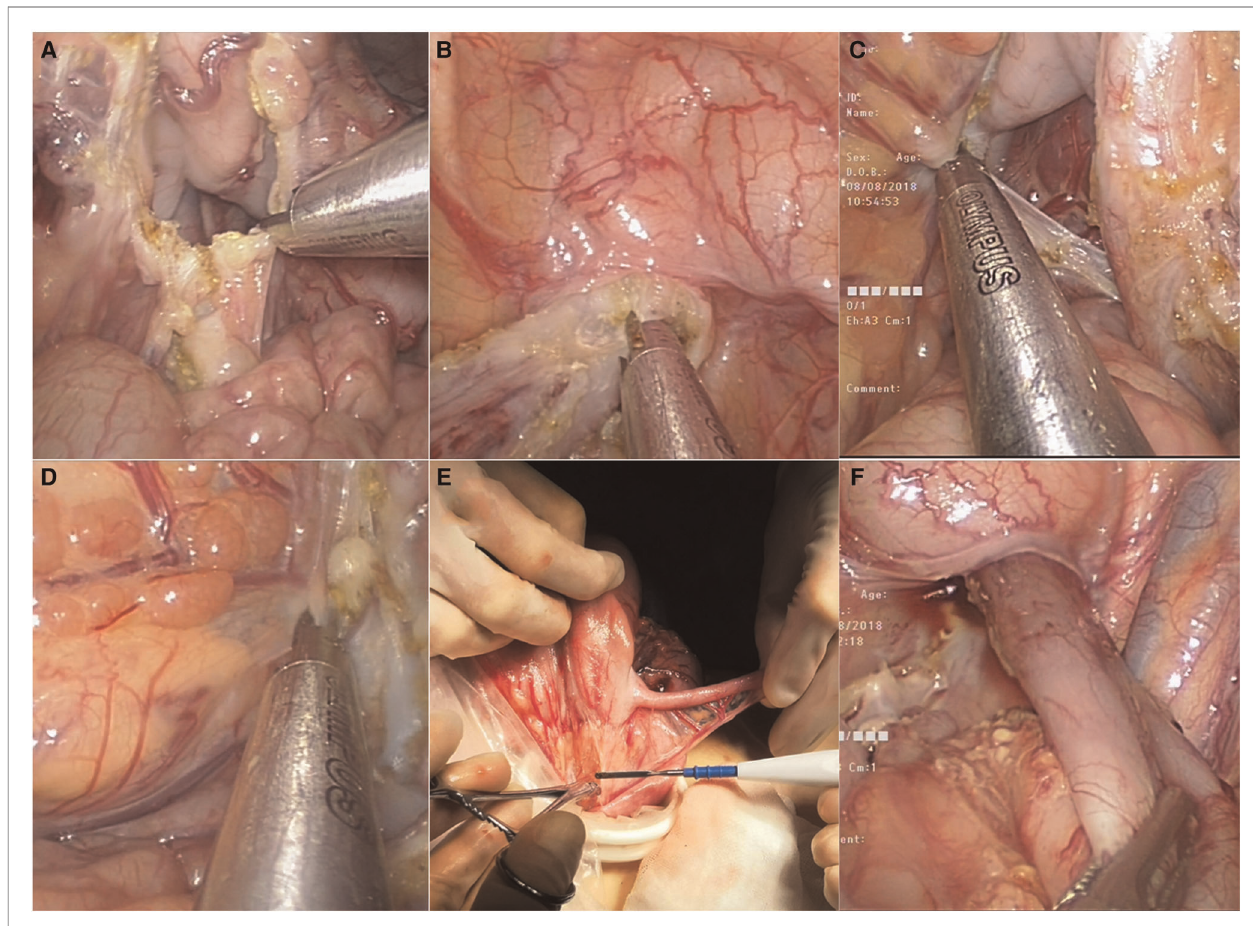
FIGURE 2 | Tu-less. ( A ), cut off sigmoid mesentery and blood vessel; ( B ), free rectum to approximately 3 cm below the peritoneum re fl ection; ( C ), free splenic fl exure of the colon; ( D ), free transverse colon; ( E ), pull the ileocecal bowel out of the abdominal cavity, free ileocecal bowel and remove appendix; ( F ), The ascending colon was inverted and pulled out through the anus, and no Volvulus was con fi rmed by